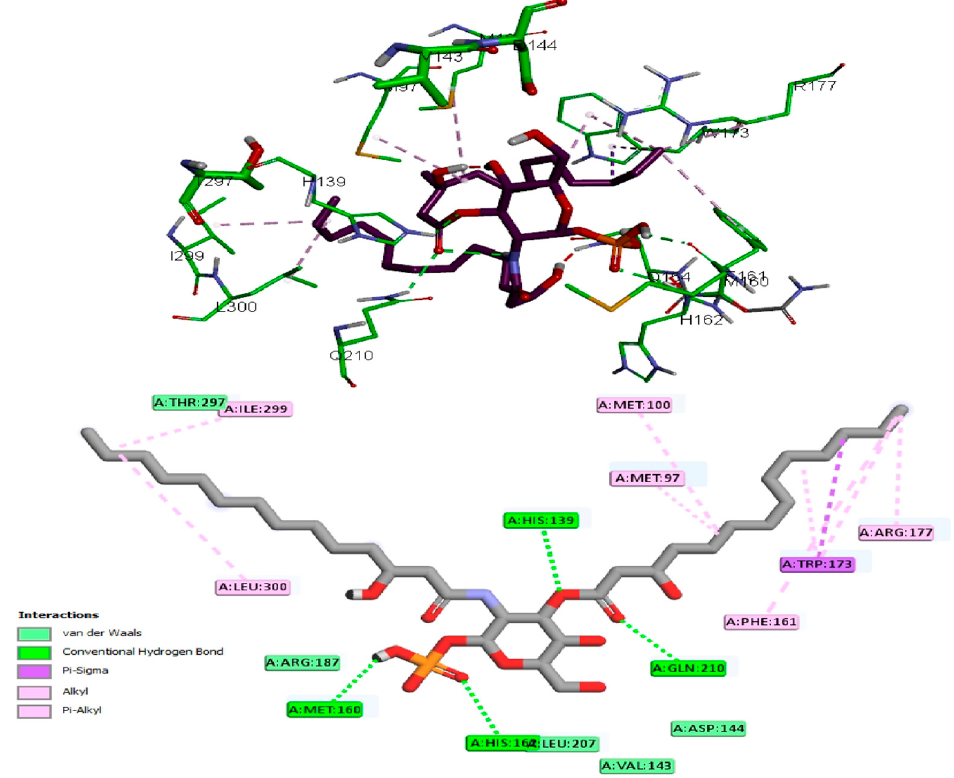
Figure 6. Docking of LAM in K. pneumoniae lipid A biosynthesis myristoyl transferase (LBMT); active site view ( Top ) and the 2D schematic presentation of interaction forces ( Bottom ).